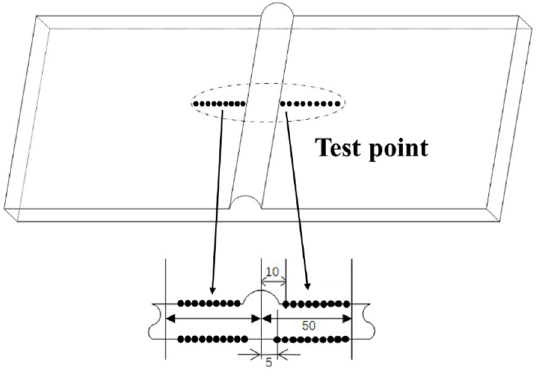
Figure 4. Residual stress distribution test location (in mm).